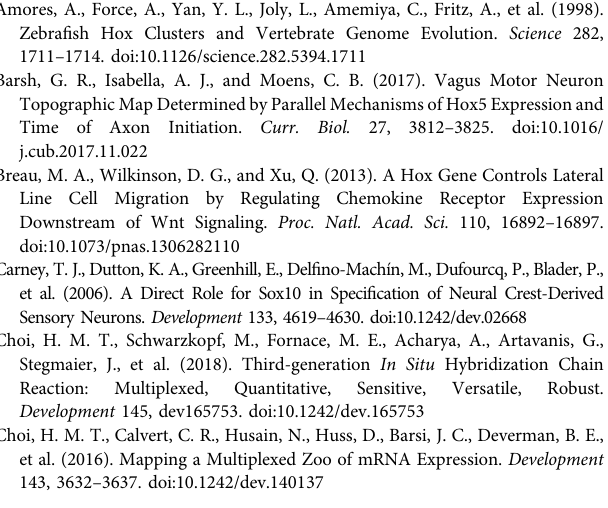
Supplementary Figure S1 | Phox2b antibody labeling is synonymous with mRNA and transgenic labeling methods. (A) 3 dpf -8.3phox2bb : kaede larva co-labeled via WICHCR protocol (Ibarra-García-Padilla et al., 2021) showing Kaede labeled cells (green), phox2bb mRNA (magenta), and Phox2b protein (cyan). (B) Inset images in